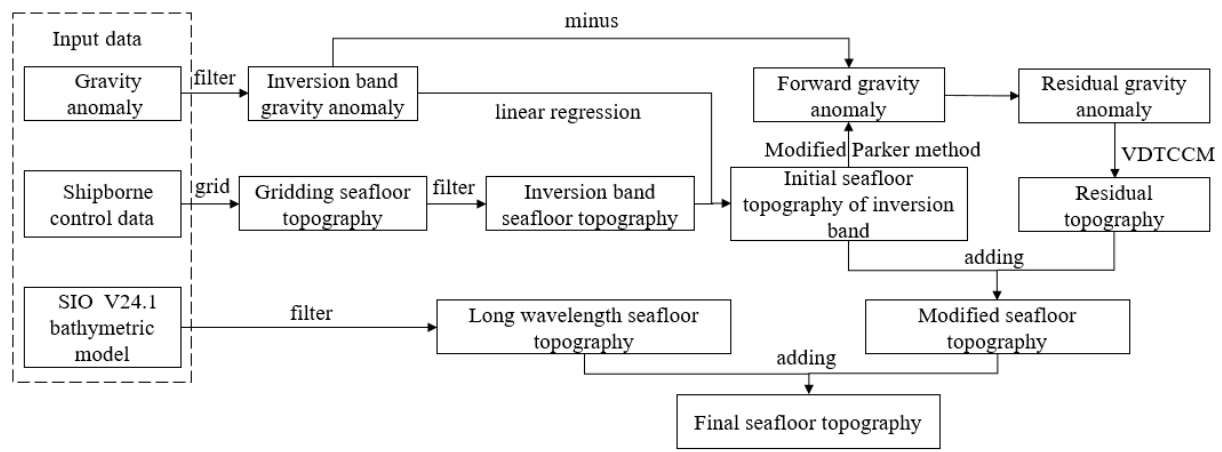
Figure 6. Flowchart of the seafloor topography inversion